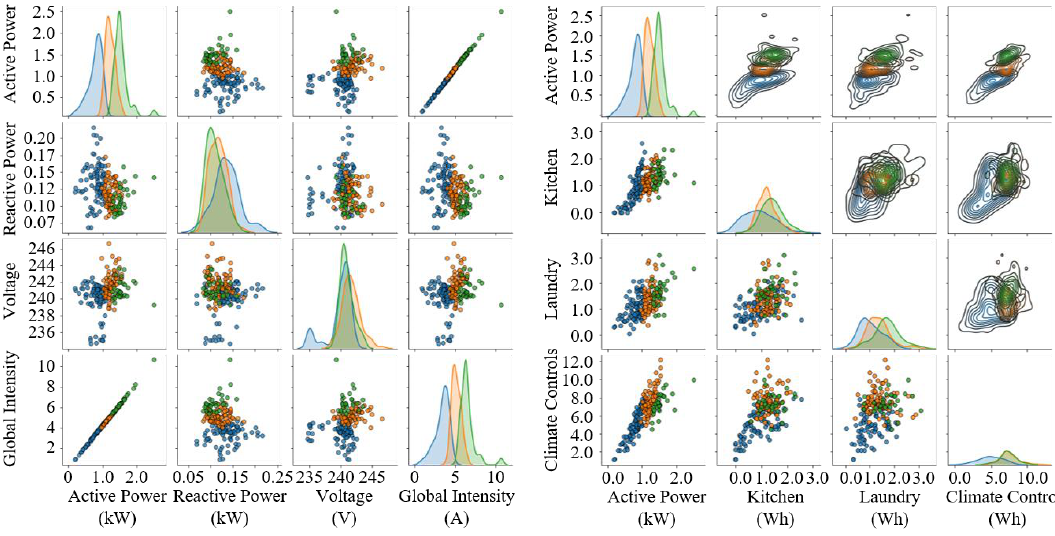
Figure 2. Results of multivariate correlation of the energy attributes by the consumption level.